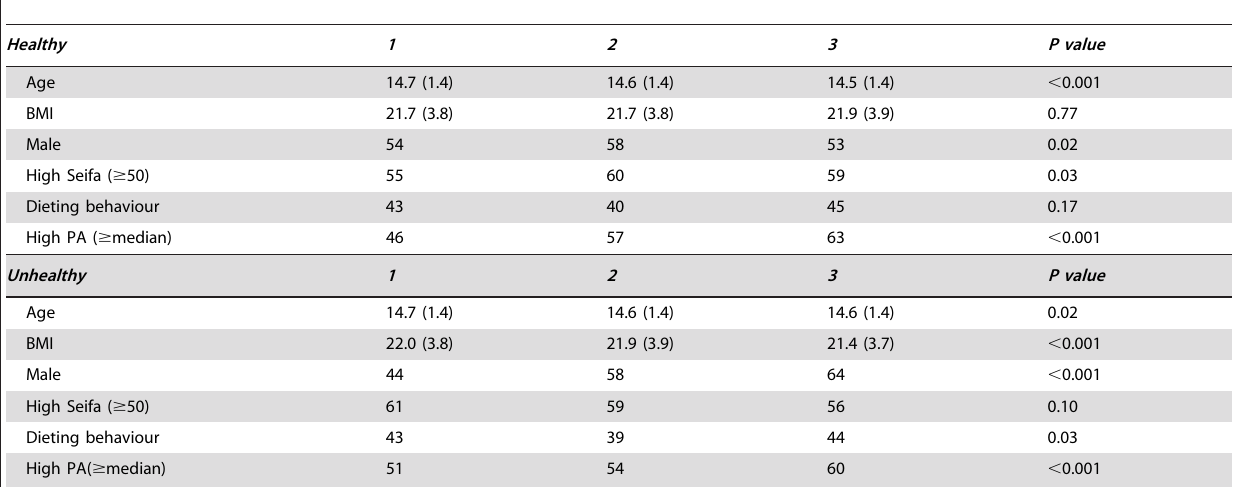
Table 1. Characteristics of study participants by category of diet quality